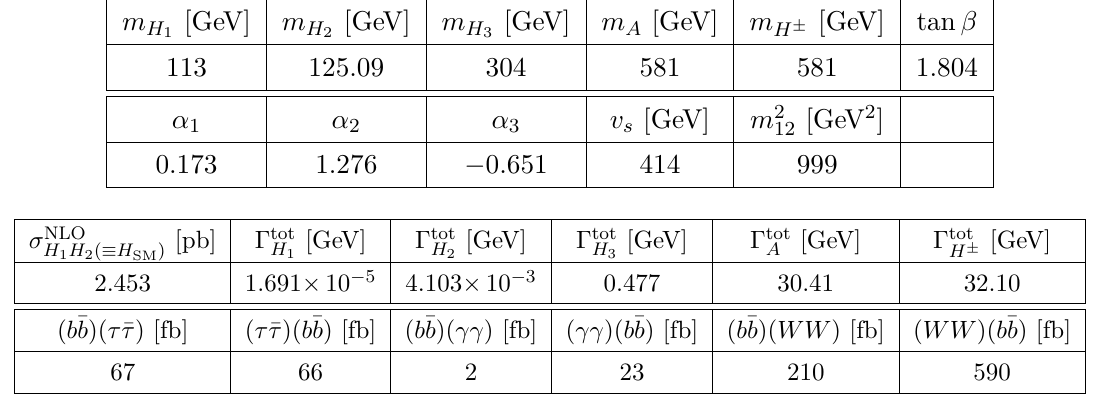
Table 27 . BP13 Upper: N2HDM-I input parameters. Lower: further information on this point.